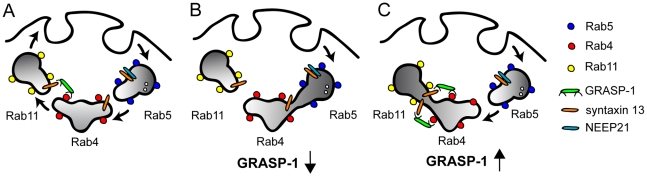
Model for the role of GRASP-1 in endosome recycling.Endosomes can be viewed as mosaic distribution of Rab4, Rab5, and Rab11 domains that dynamically interact via effector proteins and SNAREs. The Rab5 domain allows entry into the early/sorting endosome, whereas the Rab4 and Rab11 domains contain the machinery that is necessary for sorting and recycling membranes and receptors back to the plasma membrane. (A) GRASP-1 binds to Rab4 and syntaxin 13 and couples Rab4 and Rab11 recycling endosomes. The complex formed between GRASP-1 and t-SNARE syntaxin 13 might mediate fusion between Rab4 and Rab11 endosomes. (B) Absence of GRASP-1 interferes with complex formation at the recycling step, causing cargo accumulation in early endosomes, impairment of receptor expression, and changes in spine morphology. (C) Overexpression of GRASP-1 leads to recruitment of syntaxin 13 and strongly couples Rab4 and Rab11 domains, causing accumulation of internalized receptors in recycling endosomes. Consistent with the observed decrease in AMPAR clusters [28], Caspase-3 cleavage of GRASP-1 might separate the N-terminal Rab4 domain from the C-terminal syntaxin 13 binding site and disrupt the coupling between Rab4 and Rab11 domains.